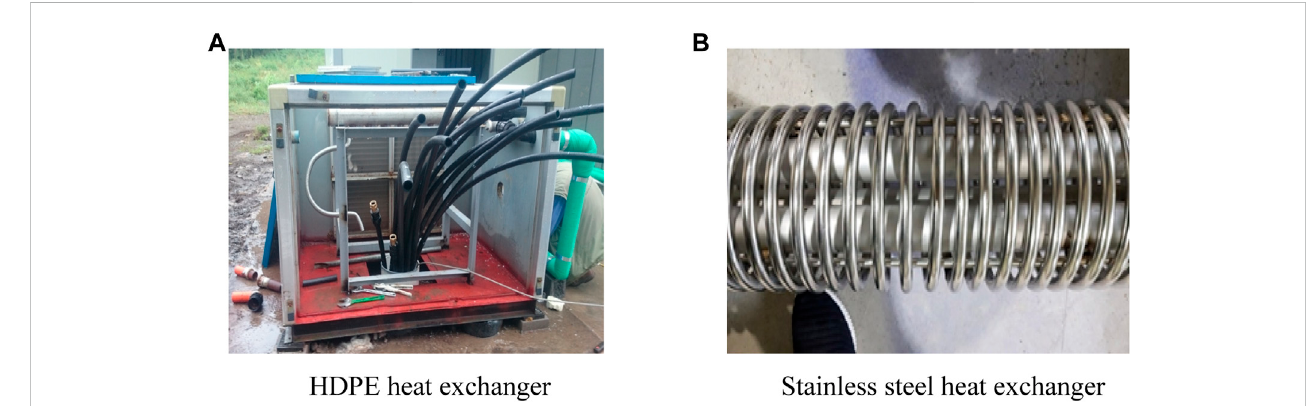
FIGURE 1 Borehole heat exchangers used in Jeju island. (A) HDPE heat exchanger, (B) Stainless steel heat exchanger.